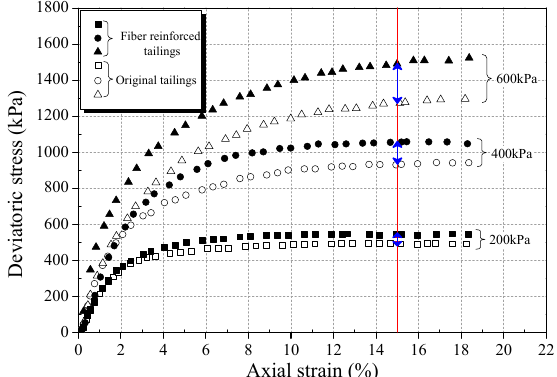
Figure 15. Stress strain curve for unreinforced and reinforced tailings sand (0.4 wt% fiber